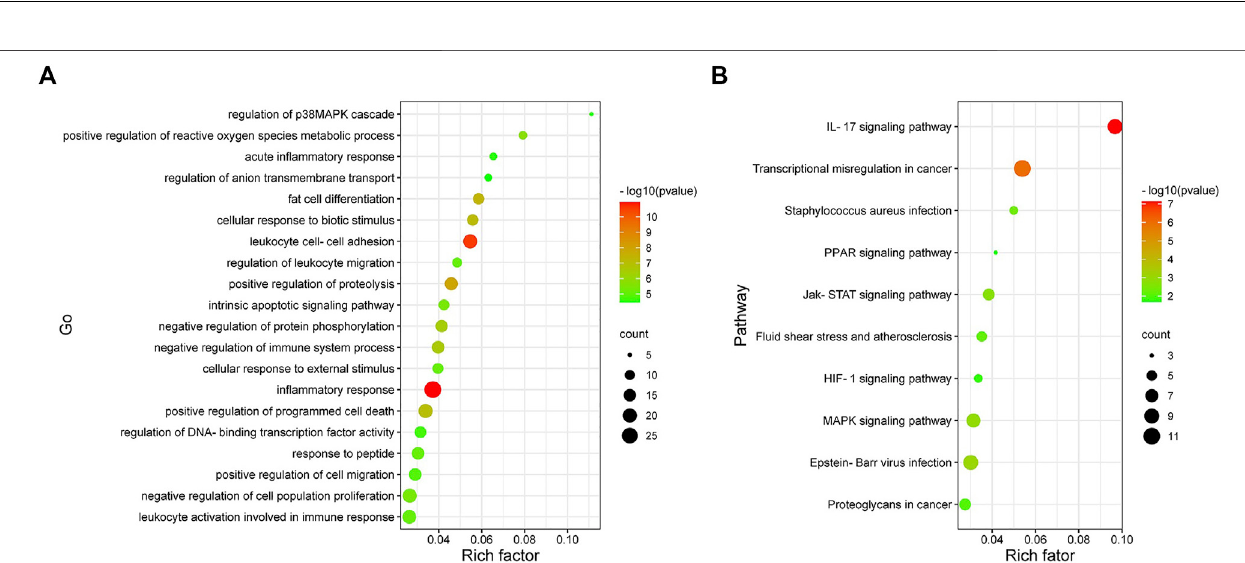
FIGURE4| Screeningofdifferentiallyexpressedgenes(DEGs). (A) VolcanooftheGSE142153datasetwiththecut-offcriteriaof|logFC| > 0.5andadj. p < 0.05. (B) The Venn diagram of common DEGs (Co-DEGs) in DEGs and Green module.